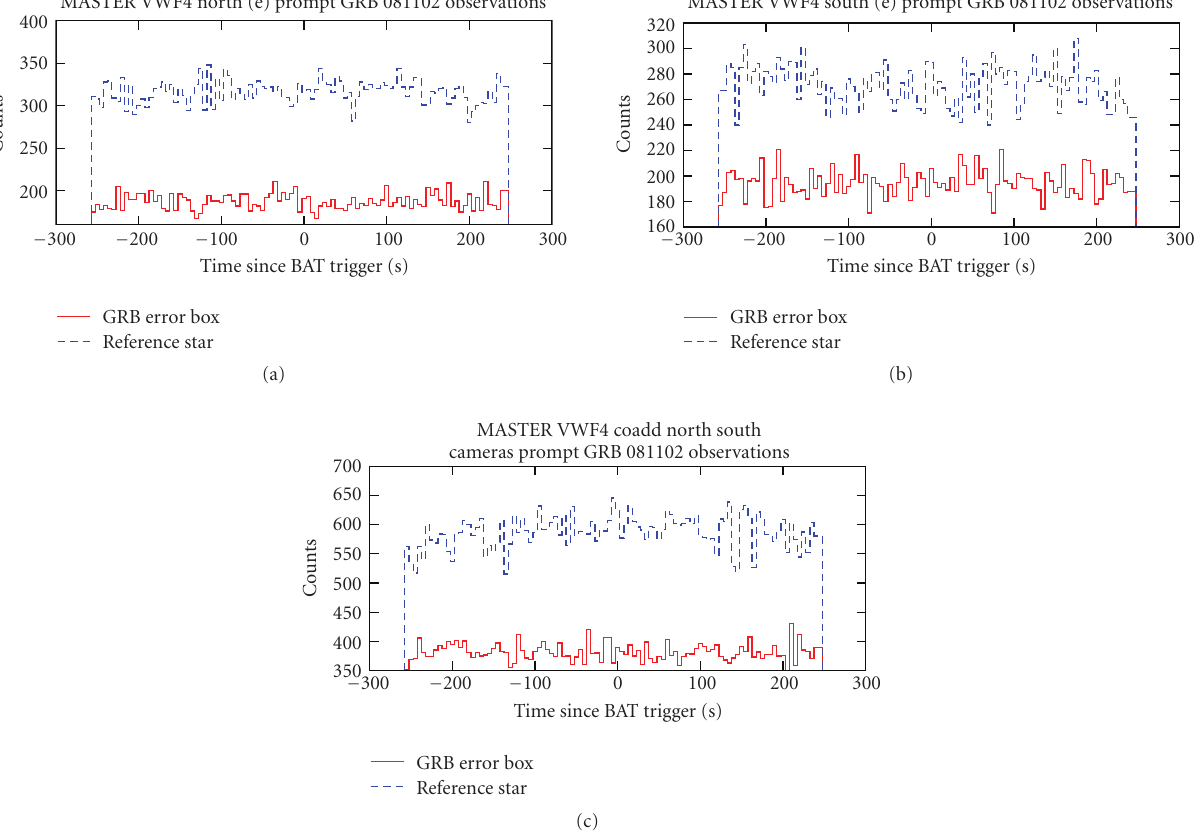
Figure 15: GRB081102. Hash (red) from the Northern and Southern cameras and from the two cameras simultaneously inside the GRB081102 error-box and the signal from the V ref = 11 . 5 m reference star (blue).